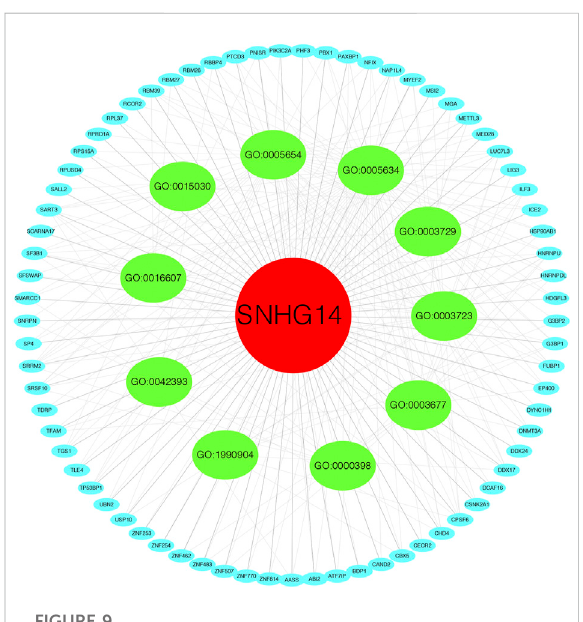
FIGURE 9 Differentially expressed gene interaction network